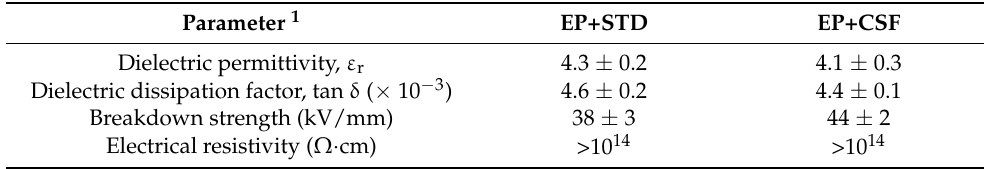
Table 6. Dielectric parameters and electrical resistance obtained for the reference system and the composite with the core-shell